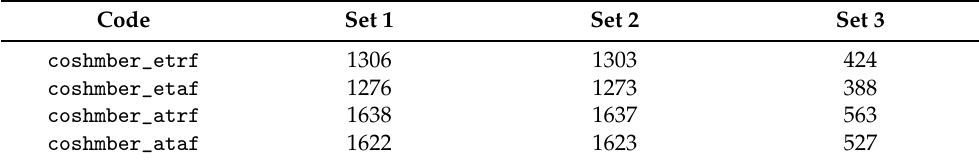
Table 4. Experiment 1: Number of matrix products for all the matrices in a set for each code.